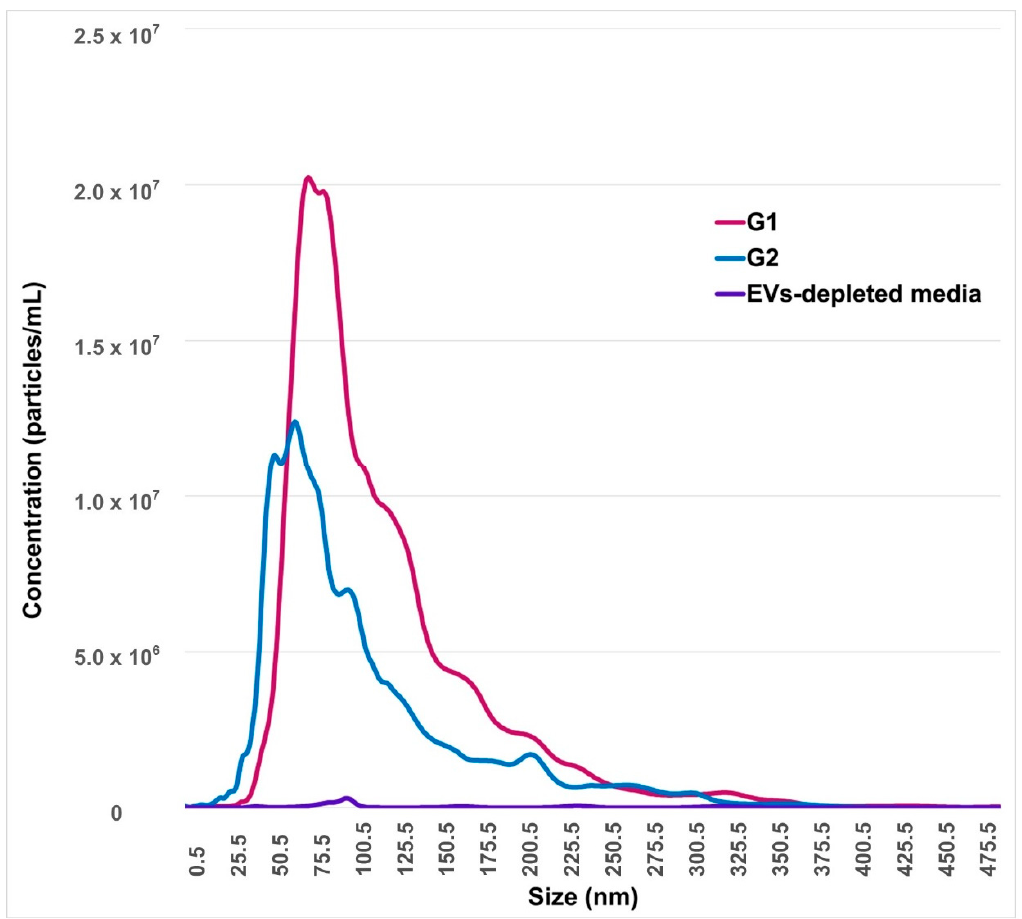
Figure 2. Nanoparticles tracking analysis of embryo-conditioned culture media. The horizontal bars indicate particle size range, while the y-axis indicates concentration of nanoparticles according to EVs size. G1: conditioned-culture media by embryos arrested in the 8–16-cells stage. G2: conditioned-culture media by embryos that reached blastocyst stages at day 7. EVs-depleted synthetic oviduct fluid (SOF) medium is considered as the negative control.